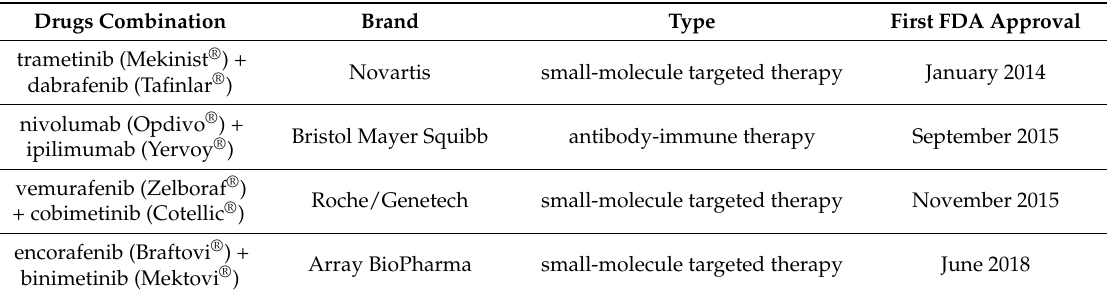
Table 2. FDA approved melanoma drugs combination